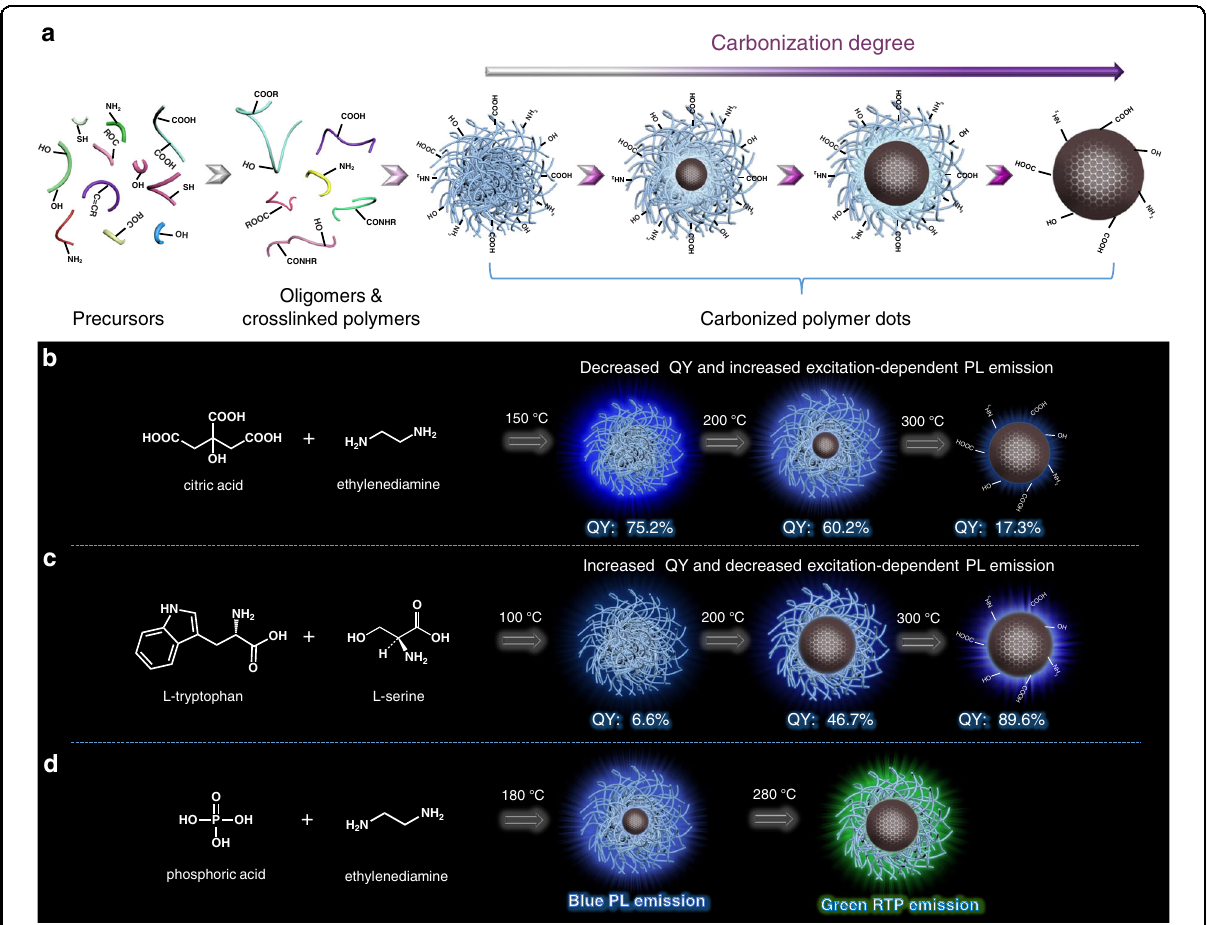
Fig. 1 Polymerization – carbonization process for the synthesis of CPDs. a Schematic representation of the hydrothermal – polymerization – carbonization process for the preparation of CPDs. In fl uence of the carbonization process on the optical emission properties of typical CPD systems prepared from ( b ) CA and EDA, ( c ) L-tryptophan and L-serine, and ( d ) PA and